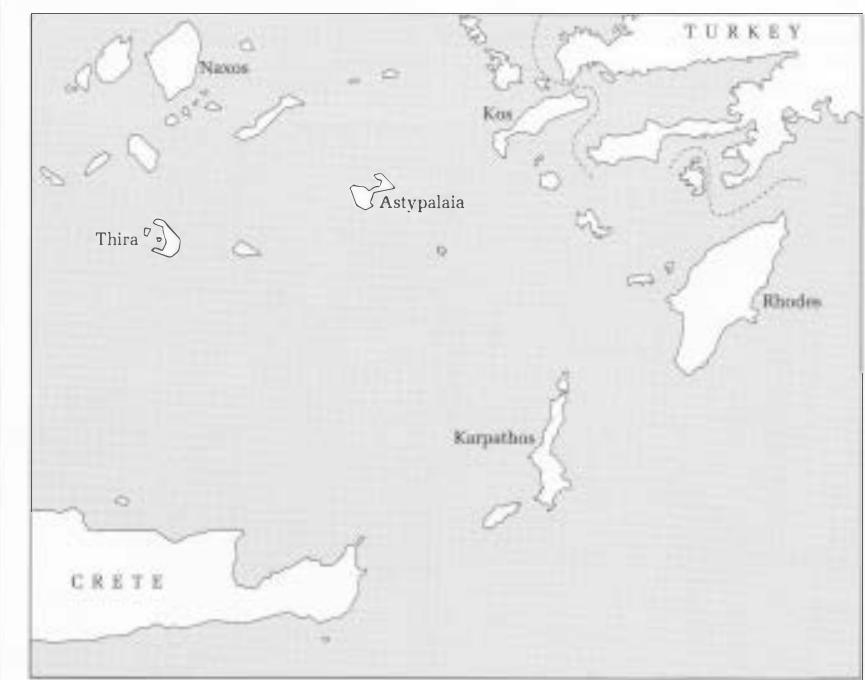
Figure 1 The southern Aegean, showing the location of the island of Astypalaia. The dashed line represents the international boundary between Greece and